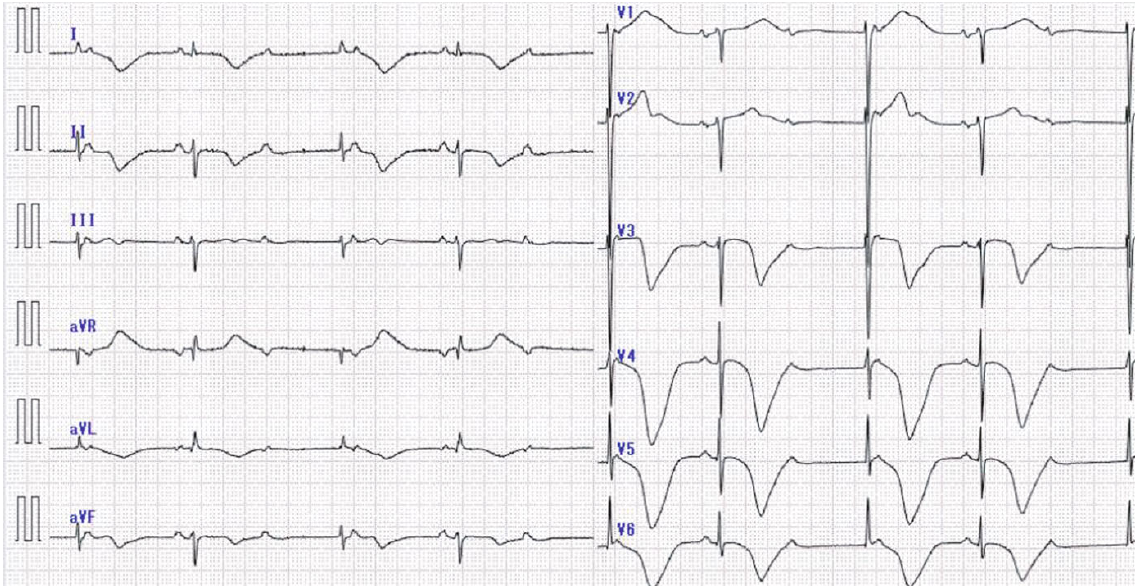
Figure 1: The initial electrocardiogram in the emergency department shows complete atrioventricular block with a heart rate of 40 beats/minute and T-wave inversion in the I, II, aVL, aVF, and V3 – 6 leads.